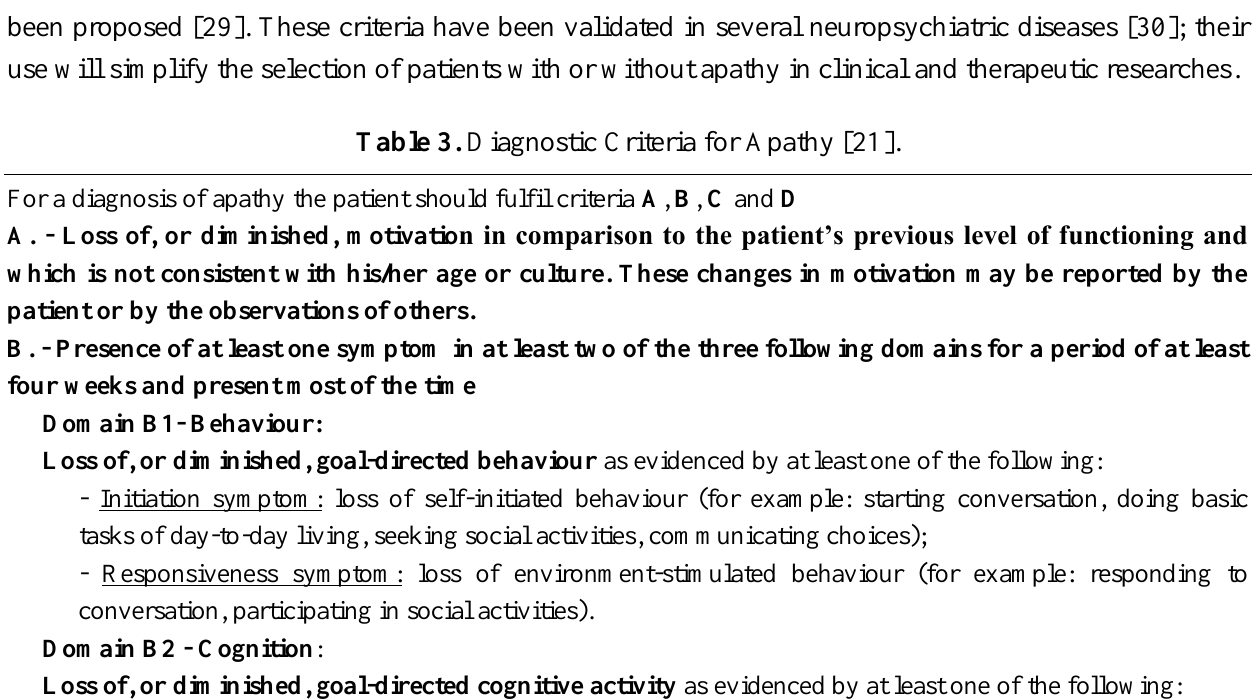
Table 3. Diagnostic Criteria for Apathy